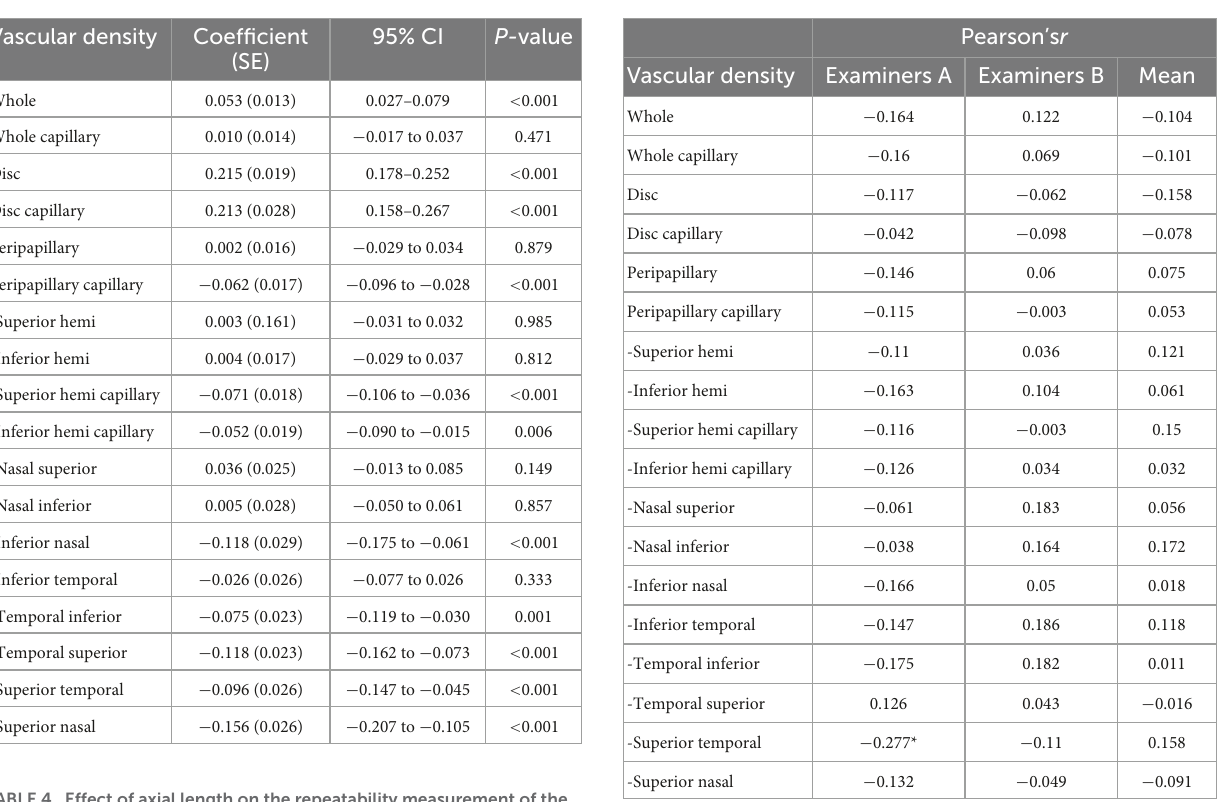
TABLE 3 Effect of signal strength index on the repeatability measurement of the papillary and peripapillary vascular density.